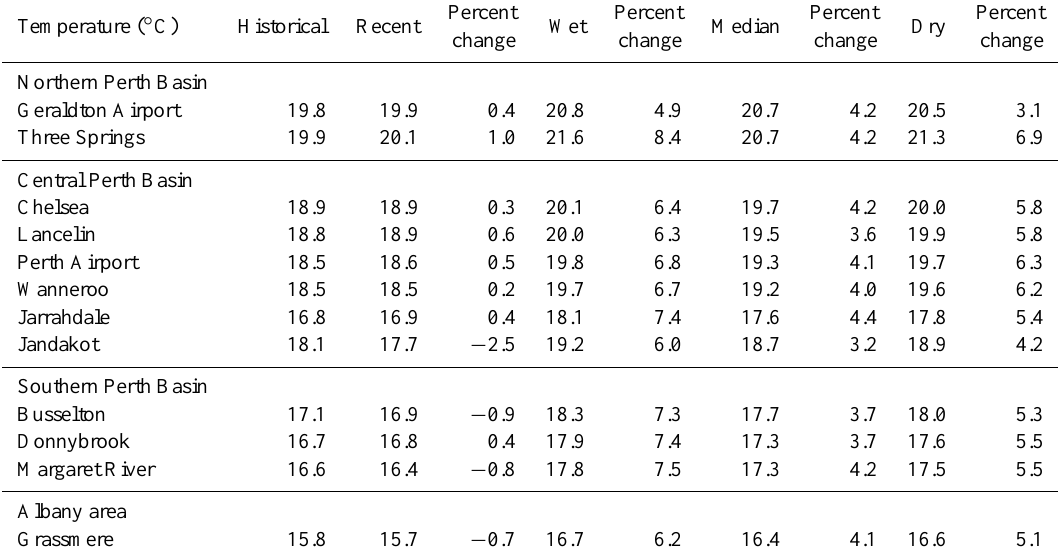
Table 2. Average daytime temperature ( ◦ C) for stations in study area, and deviation from historical record. Historical climate is from 1975– 2007; recent climate from is 1997–2007; dry climate is from a future simulation derived from INMCM +1.3 ◦ ; median climate is from a future simulation derived from MIROC +1.0 ◦ ; wet climate is from future simulation derived from GFDL +1.3 ◦